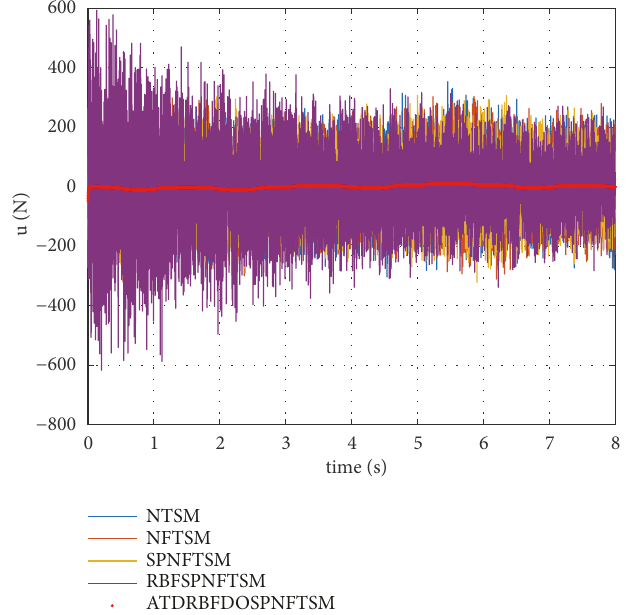
Figure 15: Control input response curve (adding